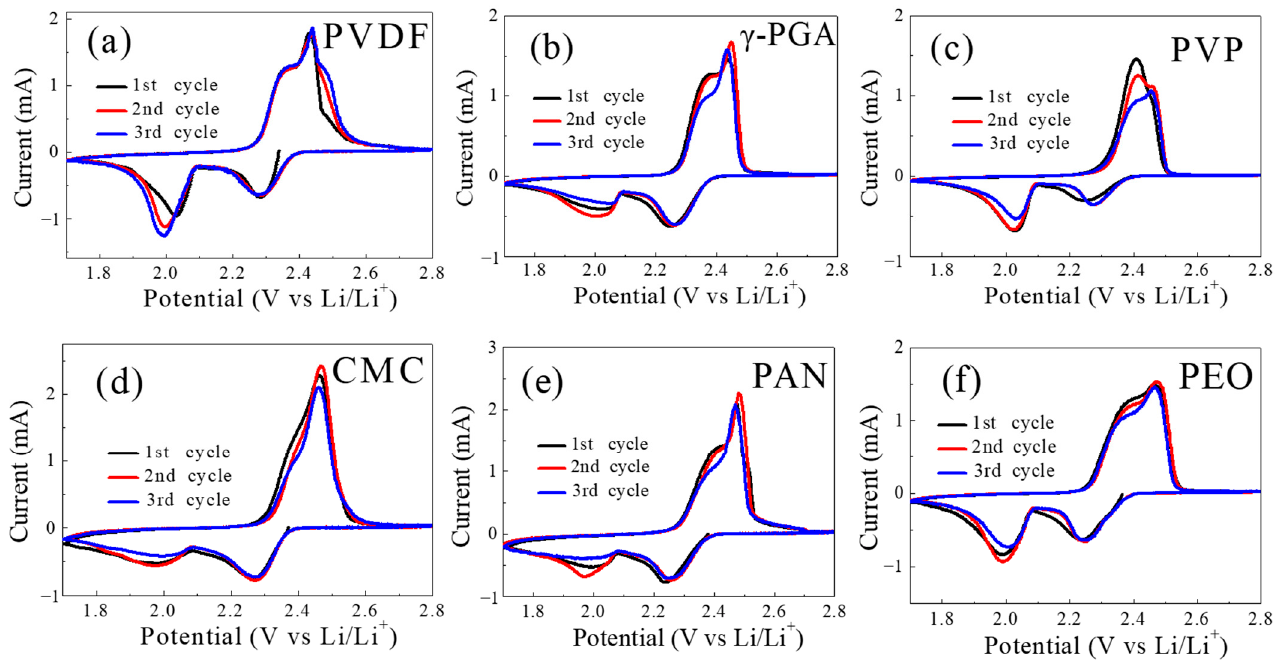
Figure 3. Cyclic voltammograms (CVs) of Li-S cells with different binders (1.7–2.8 V) at a scan rate of 0.1 mV s − 1 : ( a ) PVDF, ( b ) γ -PGA, ( c ) PVP, ( d ) CMC, ( e ) PAN, and ( f ) PEO.